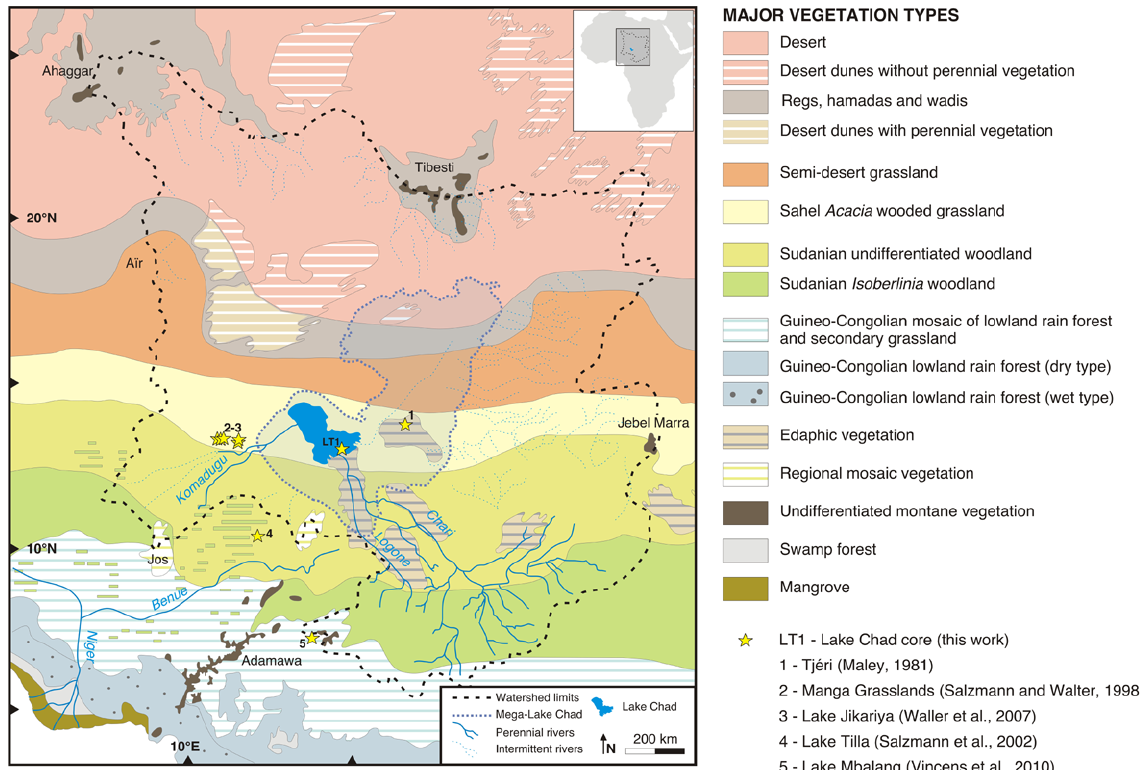
Fig. 1. Location map showing the Lake Chad Basin (LCB); the Holocene Mega-Lake Chad as reconstructed by Schuster et al. (2005) and the major modern vegetation types (from White, 1983). The modern Lake Chad is shown here at its largest extension reached during the past few